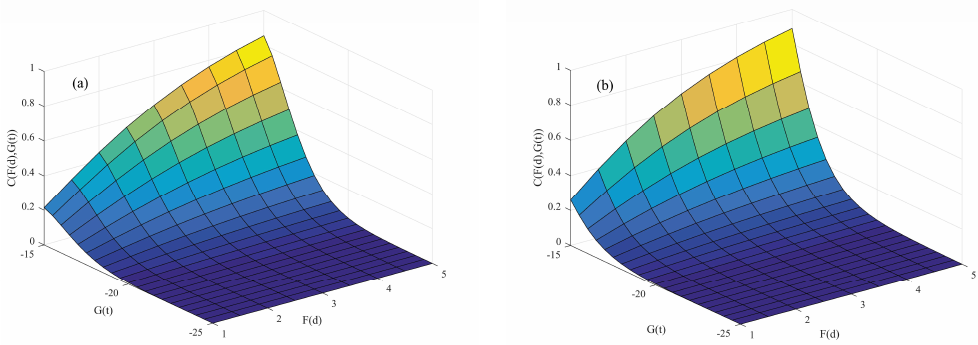
Figure 8. Joint cumulative distributions of intensity and duration of winter extreme low temperature events at Yanqing station for study periods: ( a ) 1978–1998, ( b )